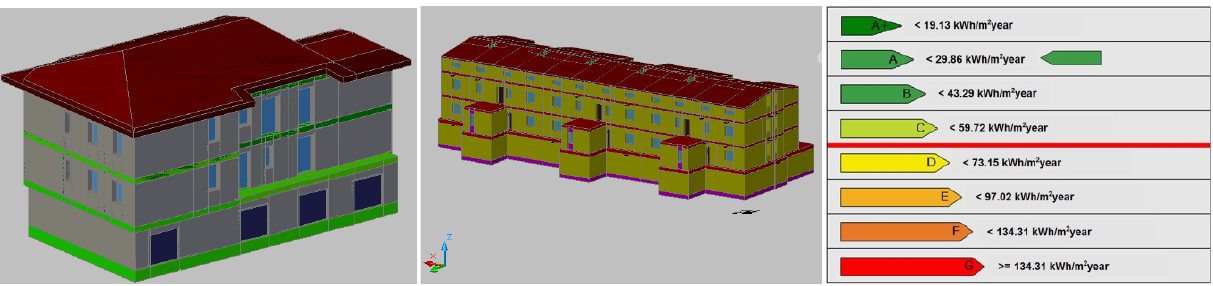
Figure 2. Model of buildings in MC4 Suite and Energy Building